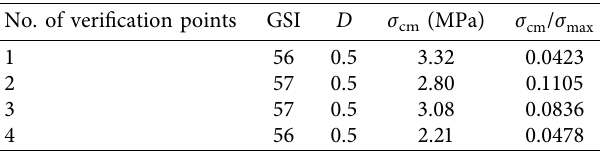
cm to σ max ratios at 4 verification